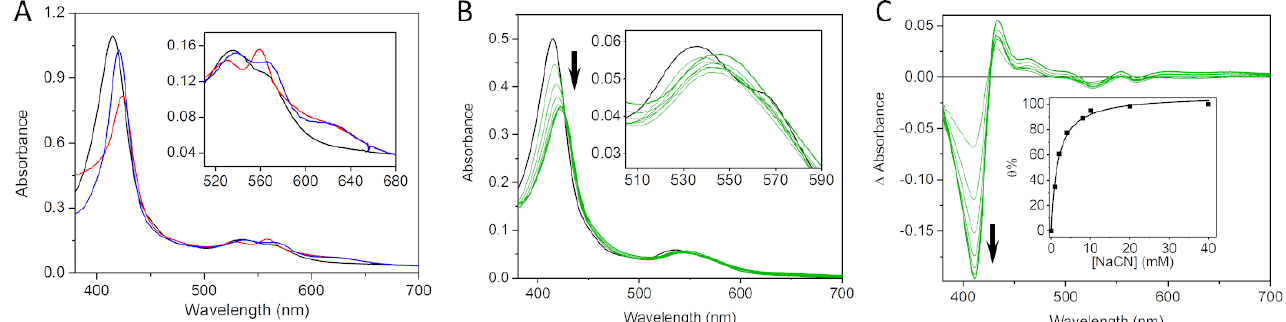
Figure 2. Oxidation state of heme in HupZ complex monitored by UV–vis spectroscopy. ( A ) the binary complex of 10 µ M HupZ-heme (black), reduced HupZ-heme complex with 1 mM dithionite (red), and CO adduct of the reduced HupZ-heme complex (blue). ( B ) HupZ (5 µ M)-heme complex (black) titrated with NaCN up to 2 mM (green). ( C ) Difference spectra of panel B with representative titration steps shown as thin green lines and the final 2 mM NaCN shown as a thick green line. The inset depicts the percent bound of CN to heme as a function of the concentration of NaCN added. Table 1. UV–vis characteristics of heme-HupZ-V5-His 6 complex in different oxidation states and H111A variant. Identity Soret Band